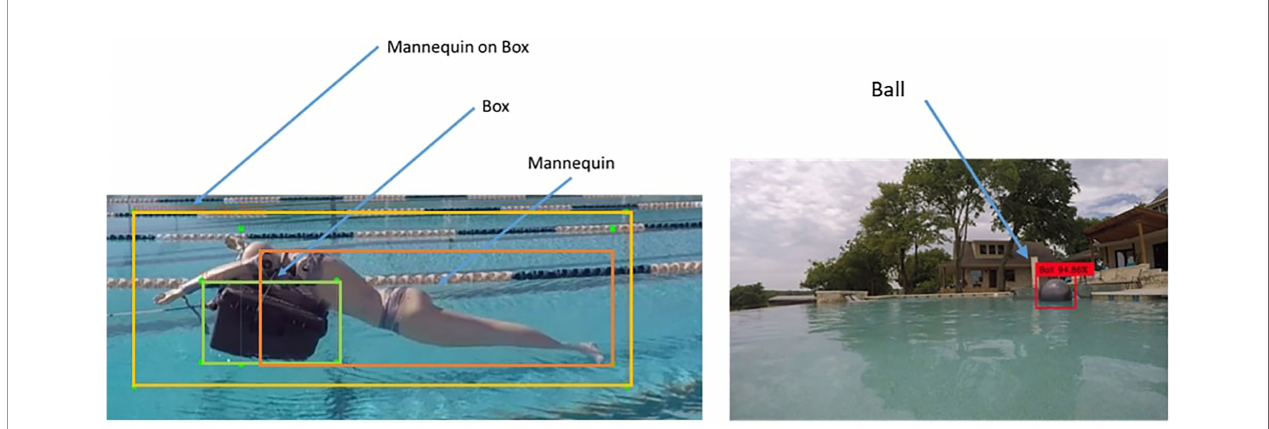
FIGURE 6 | Labels for training the object detection model: [Left Panel] To replicate PiW we utilized a mannequin. In addition we also labelled a box and a combination of mannequin on box to show the PiW is using a support to keep themselves a fl oat, [Right Panel] label to identify spherical shaped object in this case a